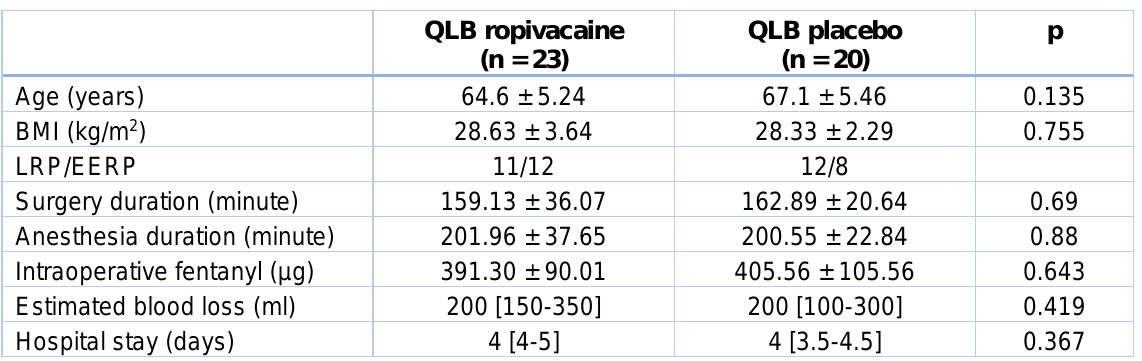
Table 1: Demographics and perioperative